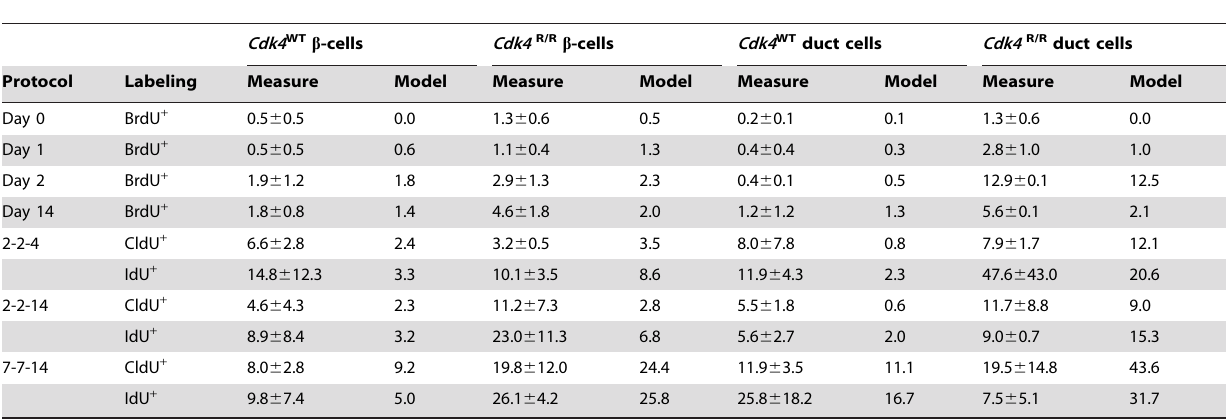
Figure 4. Proliferation of b -cells and ductal epithelial cells of Cdk4 WT and Cdk4 R/R mice after pancreatectomy. Changes of quiescent, active, and proliferated cell numbers ( n Q , n A , and n P ) normalized by initial active cell number; proliferation rate of active cells; and ratio of proliferated cells among entire cell population are plotted. doi:10.1371/journal.pone.0008653.g004 non-existent in the control Cdk4 WT pancreatic ductal epithelium percentage of Pdx-1 + :CK + ductal cells increased at day 1 post- (Fig. 5B). In contrast, higher numbers of ductal Pdx-1 + :CK + cells PX in the Cdk4 WT pancreas and reached , 3% at day 14 post-PX were observed in the Cdk4 R/R pancreas before PX. The (Fig. 5B). This illustrates the capacity of normal pancreas to Table 1. Measured and model-predicted labeling